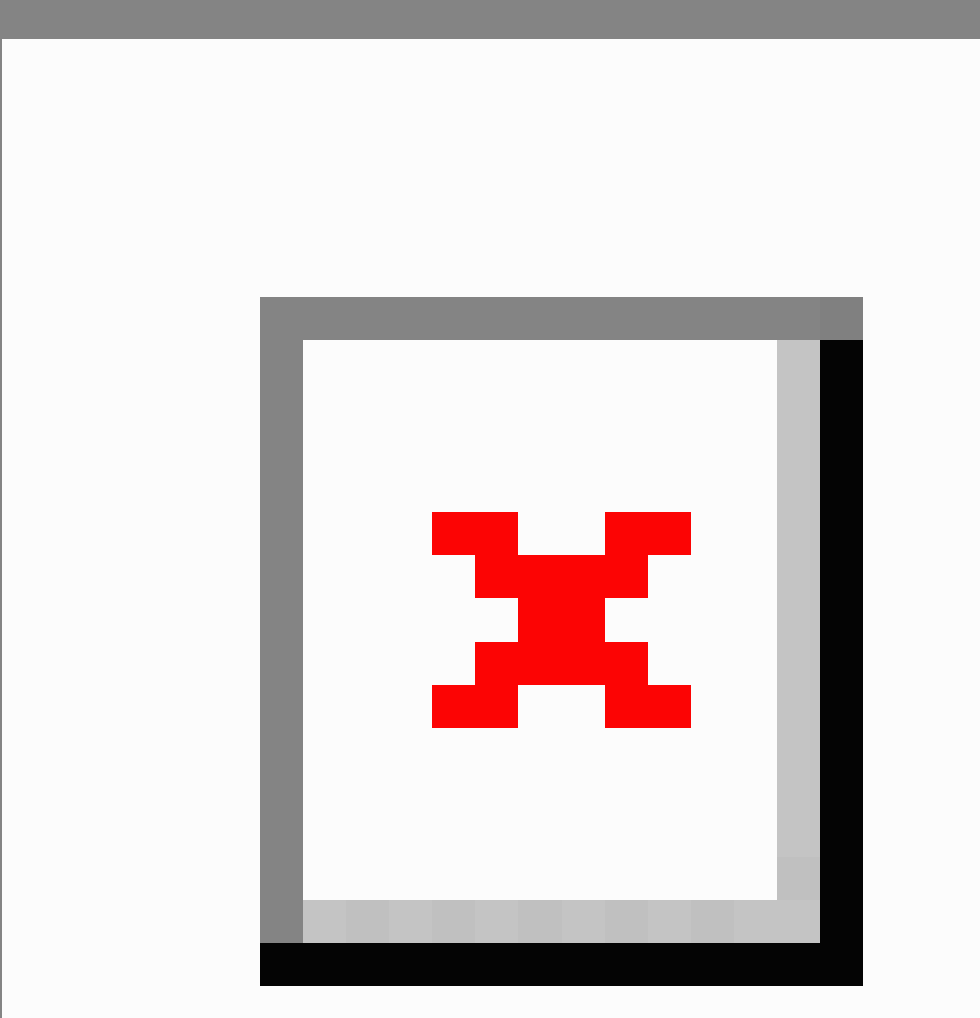
Figure 6. Example to show the calculation of Associative Medical Image Diagnosis Engine (AMIDE) in Condition